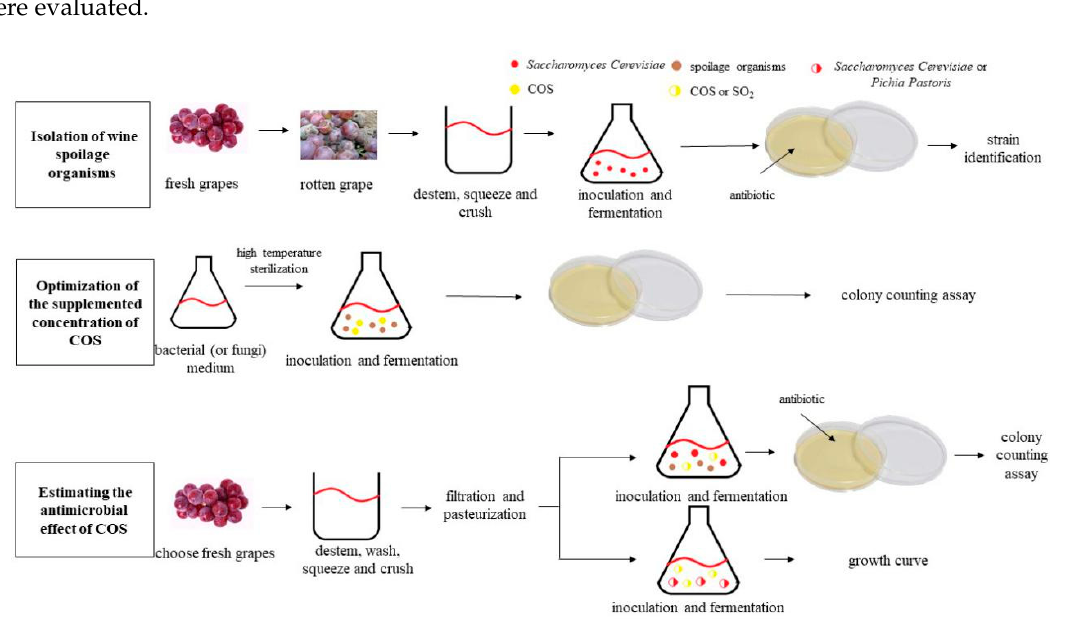
Figure 1. The workflow for investigation into whether chitooligosaccharide (COS) can be applied as an alternative to SO 2 in winemaking.